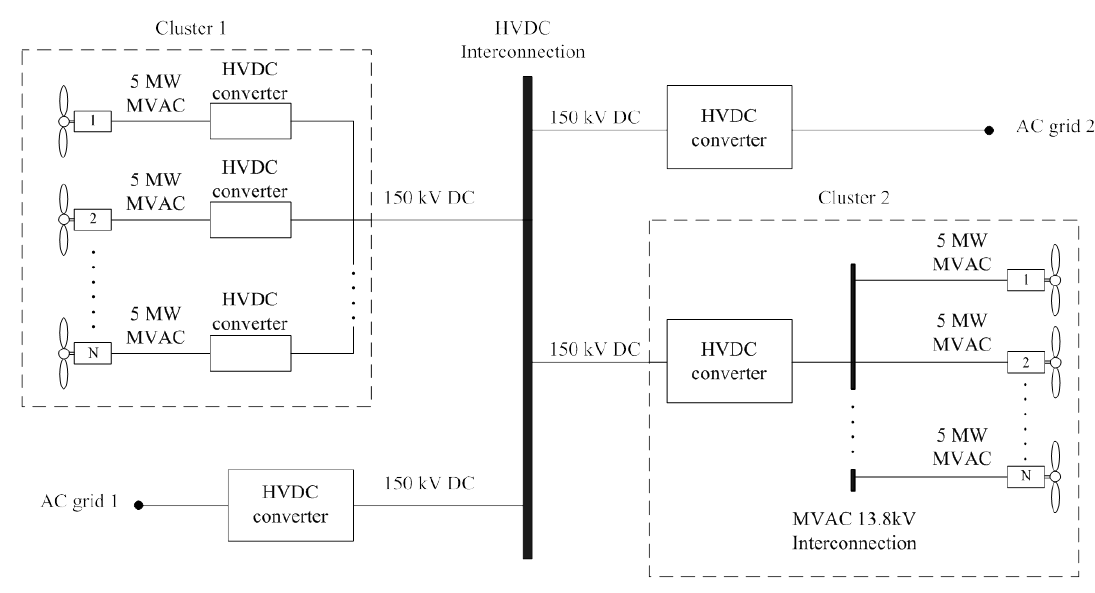
Figure 1. A simplified single line diagram of a sample HVDC interconnection of wind generation sources and ac